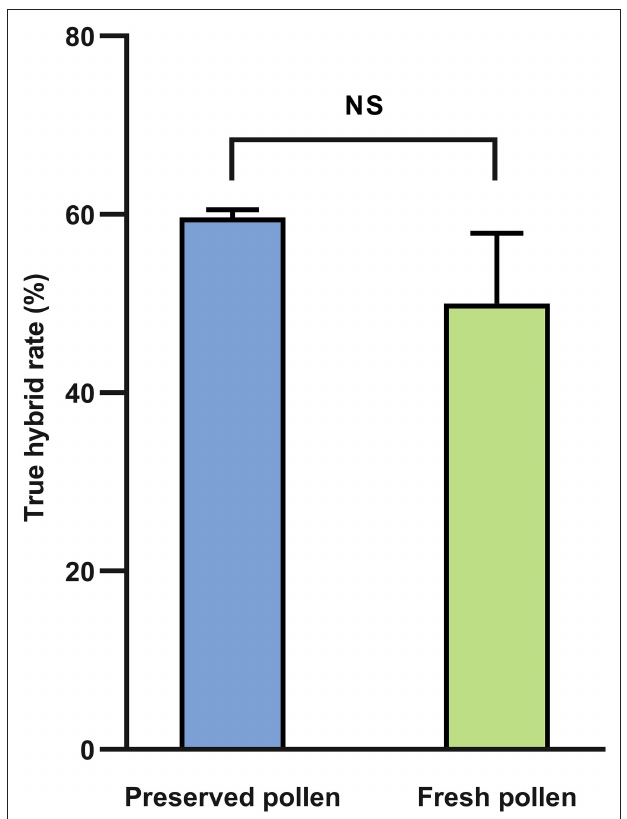
FIGURE 7 | Comparison of the true hybrid rates in F1 generation of combinations using preserved and freshly collected flowers as the pollen sources. Preserved pollen: the flowers of a purple flower variety Heihe43 at the initially-open stage were collected, dehydrated, and frozen in liquid nitrogen (LN) for 72h and then stored at − 80 ◦ C, from 15 July 2018 to 24 July 2019; Fresh pollen: Fresh flowers of Heihe 43 at the initially-open stage was collected in Heihe within 0.5h to pollinate before hybridization. Data were represented as mean ± SD of two replicates. Means of the true hybrid rates in F1 generation of combinations using preserved and freshly collected flowers as the pollen sources were separated by Duncan’s multiple range test at P < 0.05, where the F -test was